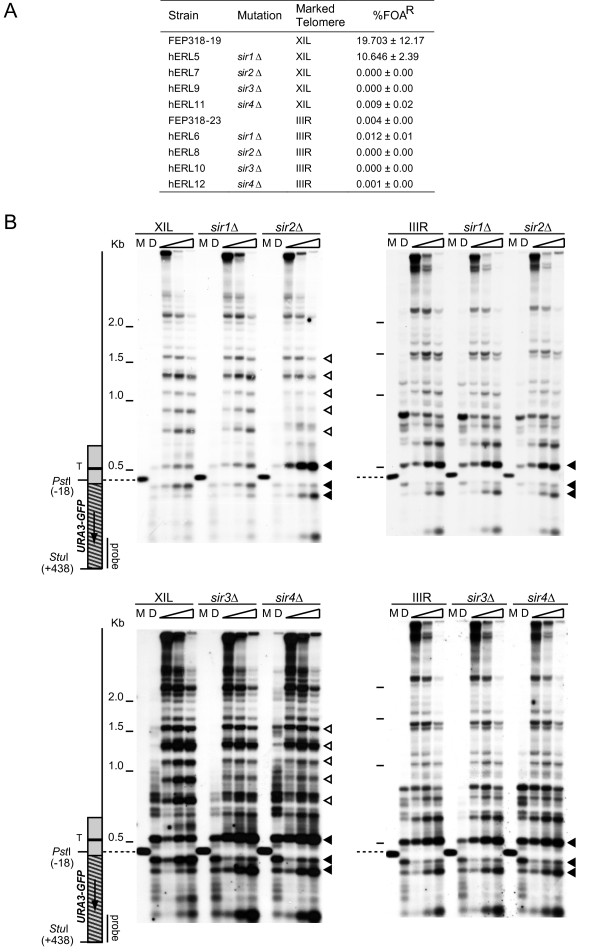
The Sir complex is required for the formation of repressive chromatin at a native telomere. (A) Frequency of fluoroorotic acid (FOA) resistance in isogenic Δsir::KanMX strains containing the URA3-yEGFP marker adjacent to the core X element at the indicated telomere. The mean and standard deviation of FOA resistance is given for each strain. (B) Chromatin structures of the XIL and IIIR telomeres were analysed in Δsir1::KanMX, Δsir2::KanMX, Δsir3::KanMX and Δsir4::KanMX strains, by MNase digestion and indirect end labelling, as described for Figure 1B.